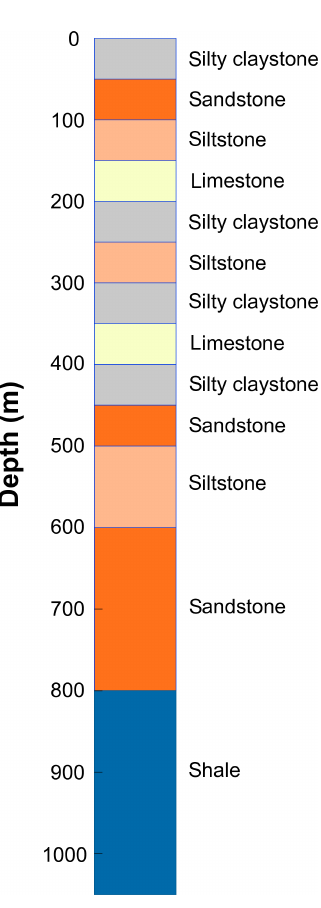
Figure 8. Vertical sequence of sedimentary rocks used for the exam- ple simulations in Sect. 4.1–4.3. The sequence is assumed to consist entirely of shale below